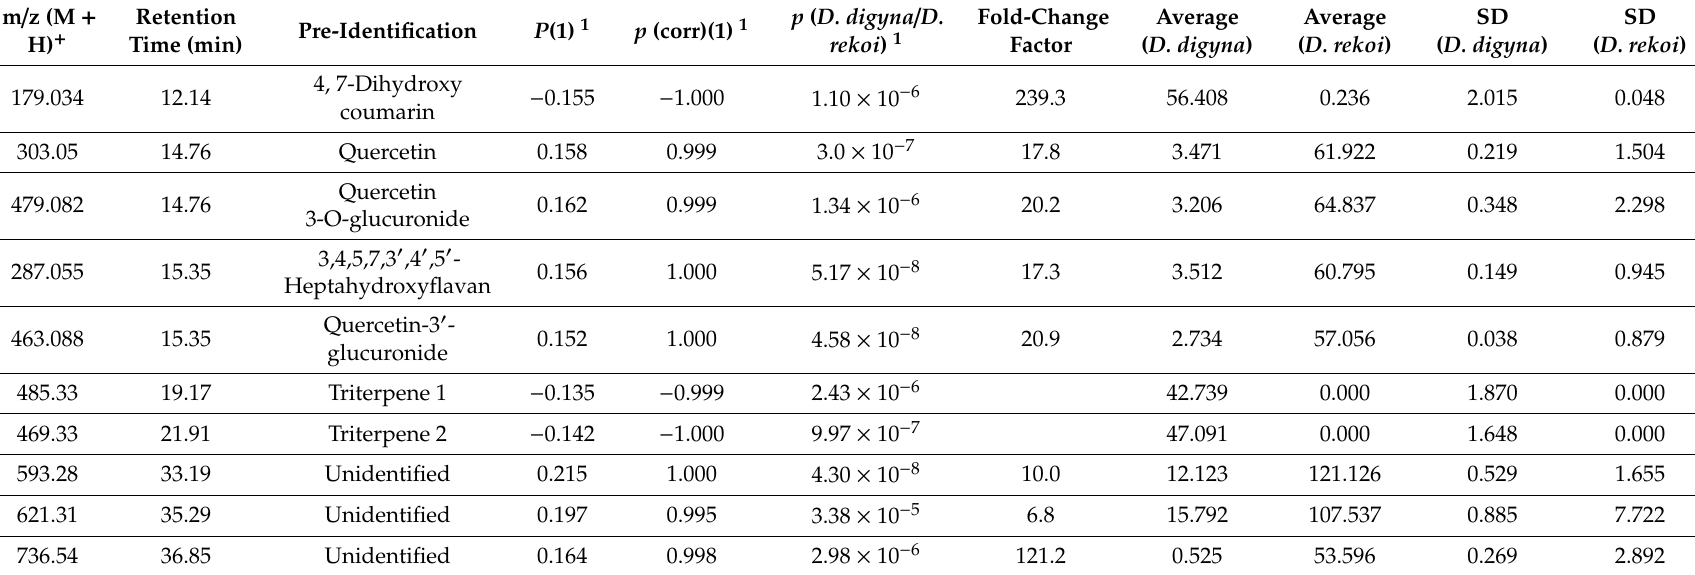
Table 1. Exact mass and most important discriminant metabolites between D. digyna and D. rekoi leaves after OPLS-DA. The intensities and factor of change are based on the average of the measured values for each exact mass in the